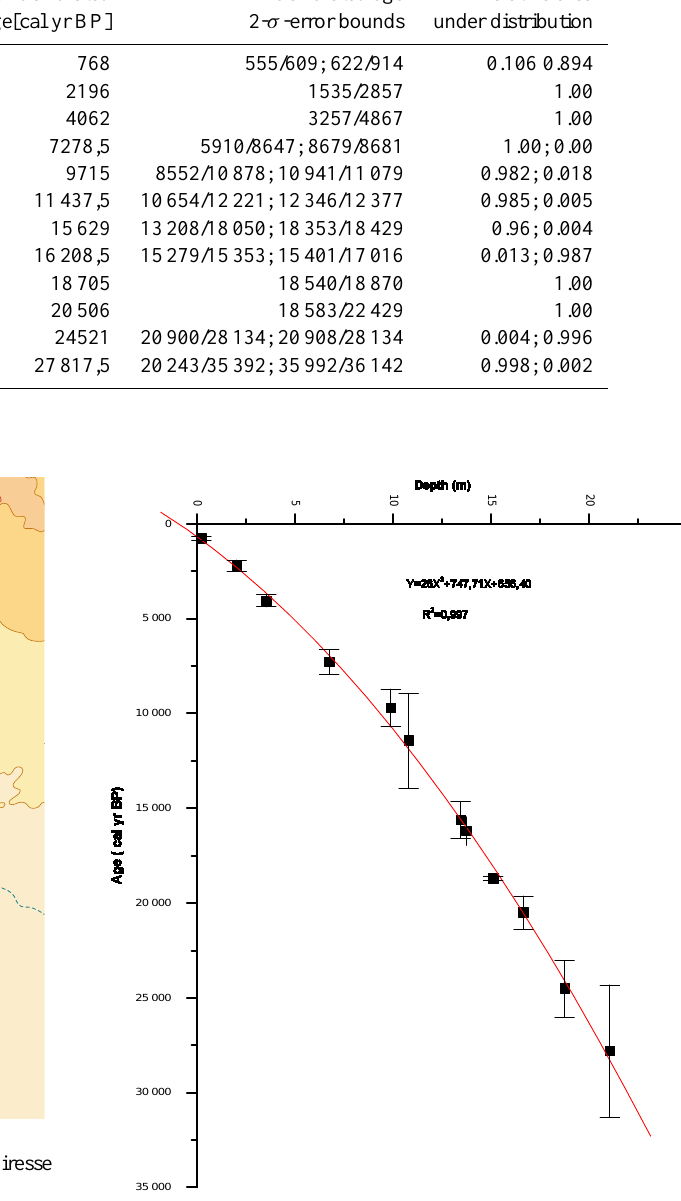
Fig. 3. Depth-age model of core BM-6 of Lake Barombi Mbo, west- ern Cameroon.